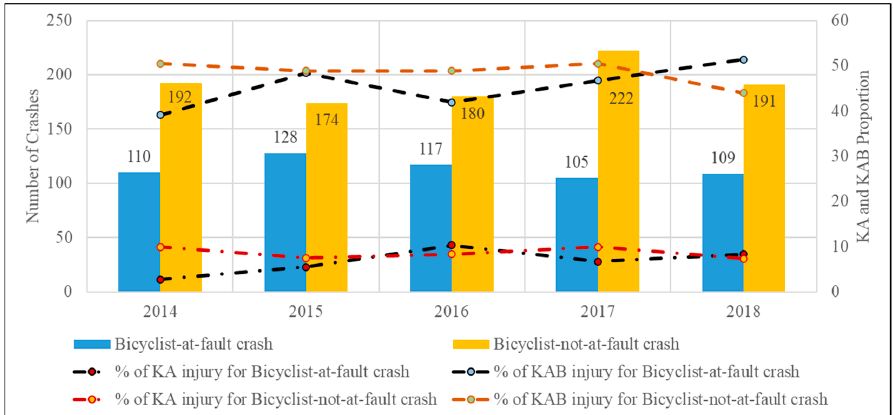
Figure 5. Annual frequency and proportions of KA and KAB injury of bicycle crashes based on party at fault.